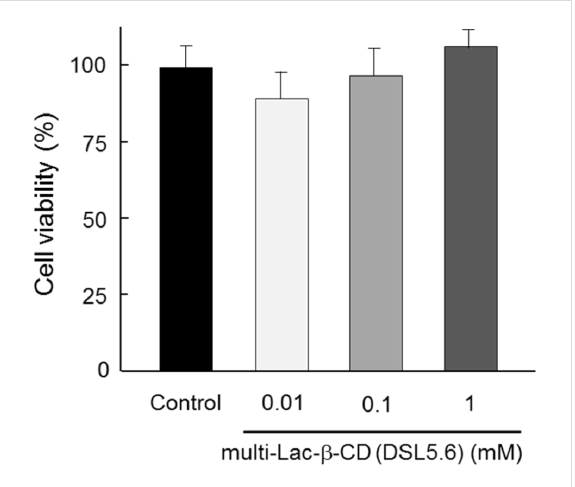
Figure 3: Cytotoxicity of multi-Lac- β -CD in NPC-like HepG2 cells after treatment for 24 h. NPC-like HepG2 cells were incubated with 150 μ L of media [FBS (–)] containing multi-Lac- β -CD (DSL5.6) at 37 °C for 24 h. Data represents mean ± S.E.M. for six experiments.